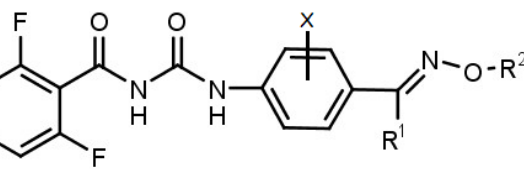
Figure 18. The 2D structure of benzoylphenylurean derivatives. R1 and R2 are radicals, and X = methyl or halogens.